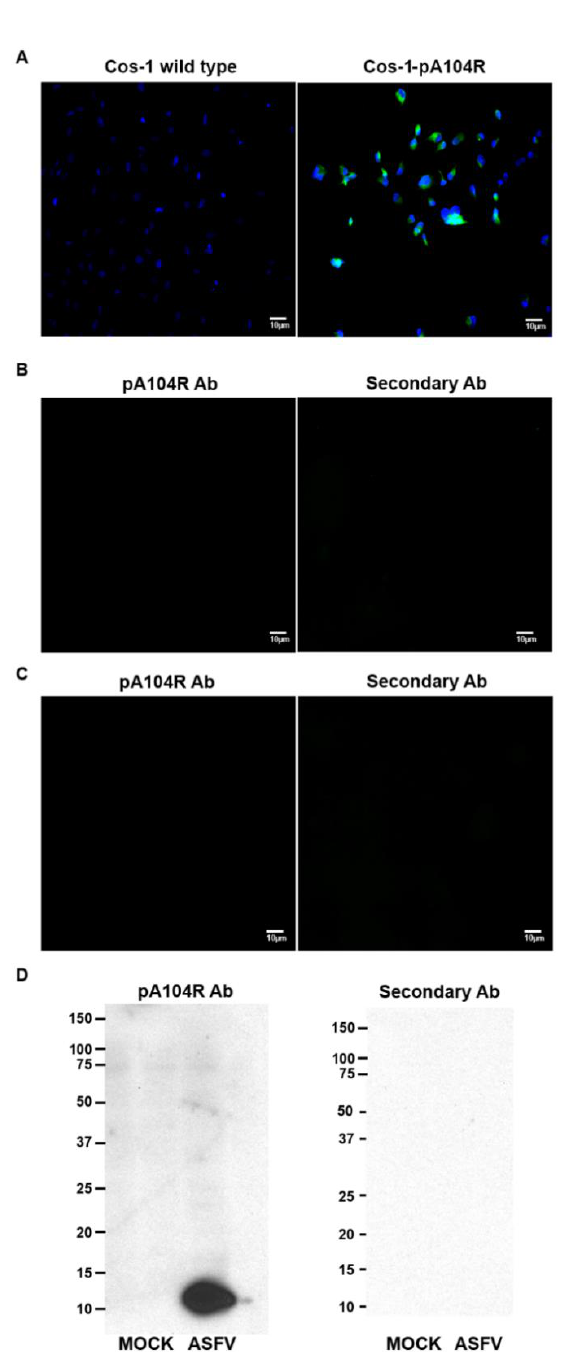
Figure A1. ( A ) Immunofluorescence studies showed ASFV-pA104R in the cytoplasm and nucleus of COS-1-pA104R cells (right image, green staining), in contrast with COS-1 wild type cells (left image). ( B ) Transformed Vero cells incubated with the in-house anti-pA104R antibody (left image) and with a goat anti-mouse secondary antibody (right image). ( C ) Transformed COS-1 cells incubated with the in-house anti-pA104R antibody (left image) and with a goat anti-mouse secondary antibody (right image). ( D ) Whole cell extracts of Vero cells non-infected and infected with Ba71V isolate (MOI = 2; 18 hpi) probed against the primary in-house antibody (anti-pA104R) and the secondary antibody (anti-mouse horseradish